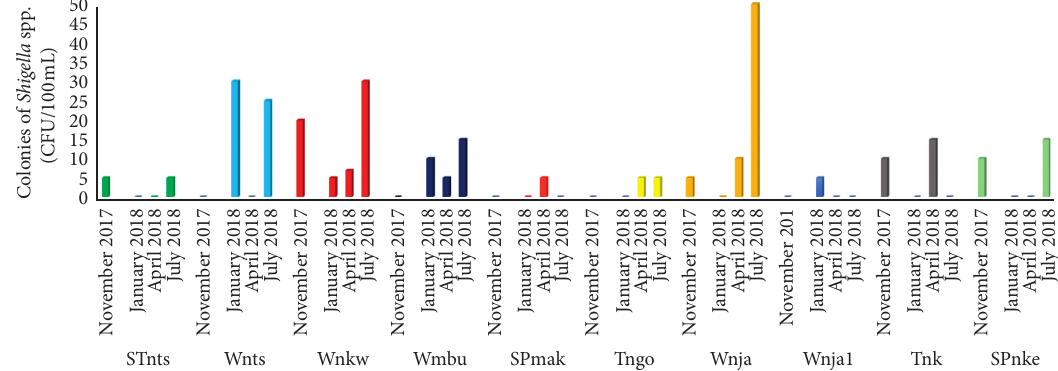
Figure 7: Colonies of Shigella spp. isolated in the sampled waters between November 2017 and July